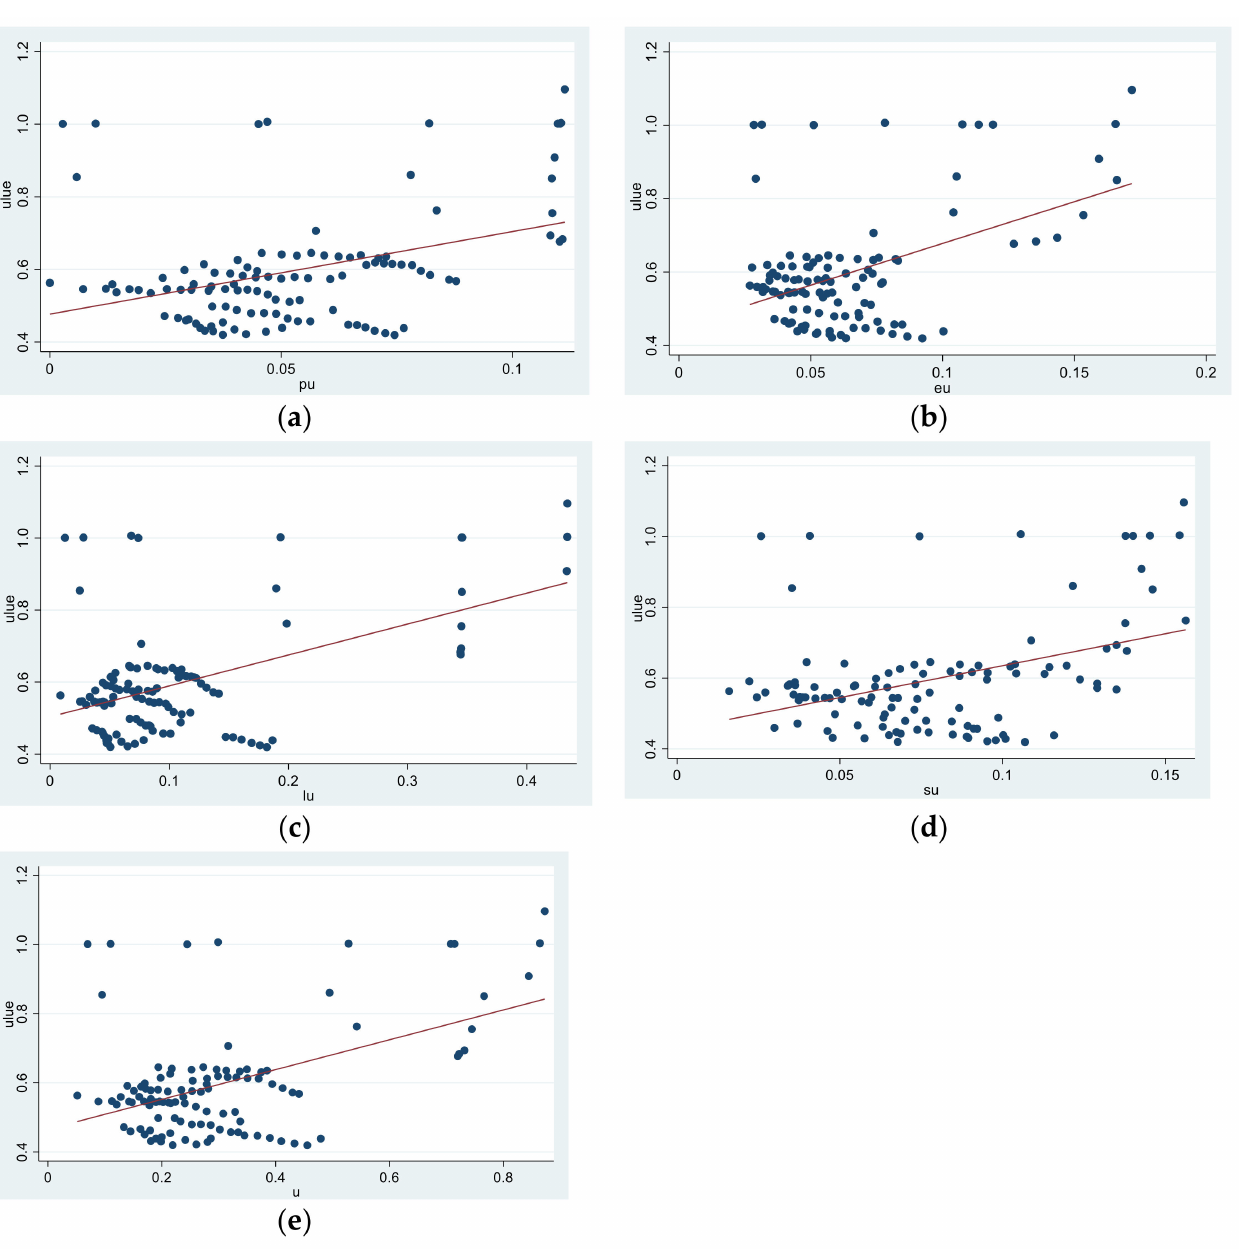
Figure 5. The linear fitting results of the relationship between the N-TU, its subsystems, and ULUE. ( a ) The urbanization of the population and ULUE. ( b ) Economic urbanization and ULUE. ( c ) Spatial urbanization and ULUE. ( d ) Social urbanization and ULUE. ( e ) N-TU and ULUE. Source: Authors’ drawing using the StataMP 16